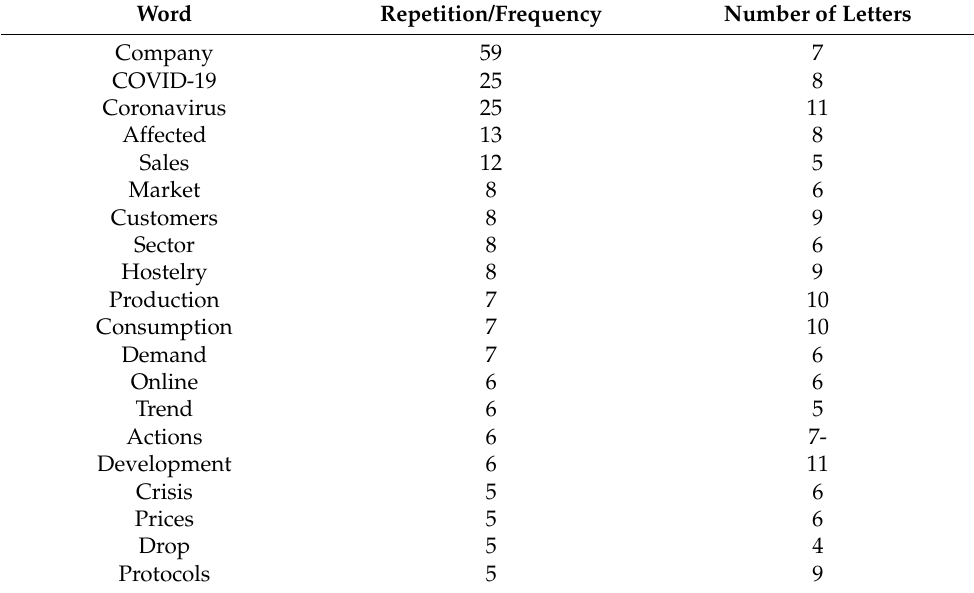
Table A3. Results of the 20 most frequent